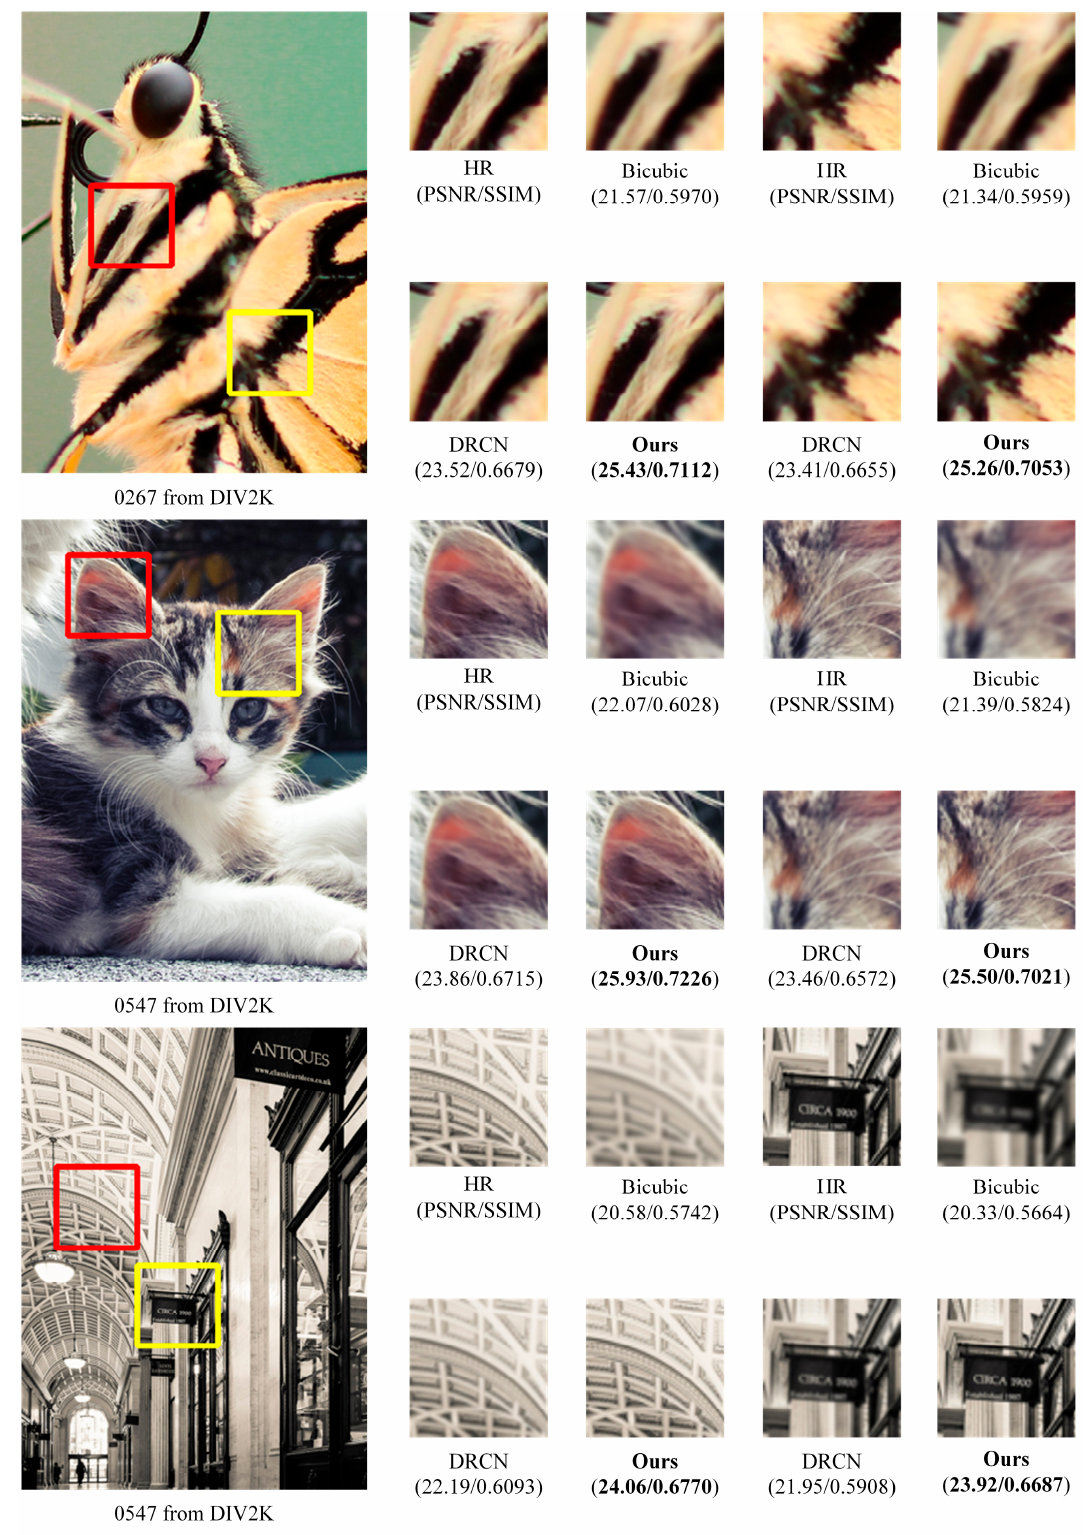
Figure 6. The qualitative super-resolution comparison between our work and DRCN with an upscaling factor of 4. Whether PSNR or SSIM, the SR results have been improved greatly.